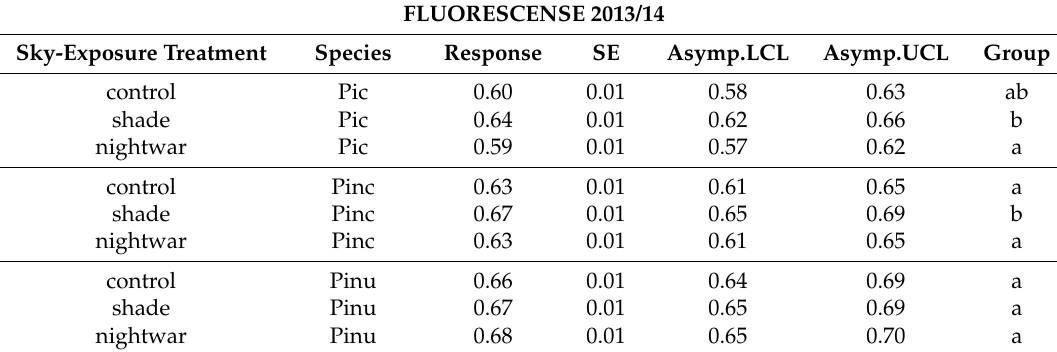
Table A1. Model estimates (response = Fv/Fm) and Tukey-adjusted comparisons (sky exposure:species), averaged over snow treatments and measurement times, in the GLM assessing the effect of snow and sky-exposure treatments on fluorescence parameter Fv/Fm measured one and 2.5 weeks after snowmelt (2014) in tree seedlings at the alpine treeline in the French Alps. Treatments: control (no roof), shade (shade roof during the day), and nightwar = night warming (shade roof during the night). Species: Pic = Picea abies , Pinc = Pinus cembra, Pinu = Pinus uncinata . SE = Standard error, Asymp.LCL and Asymp.UCL = asymptotic lower and upper control limits. Groups indicate significantly different treatment combinations per species .